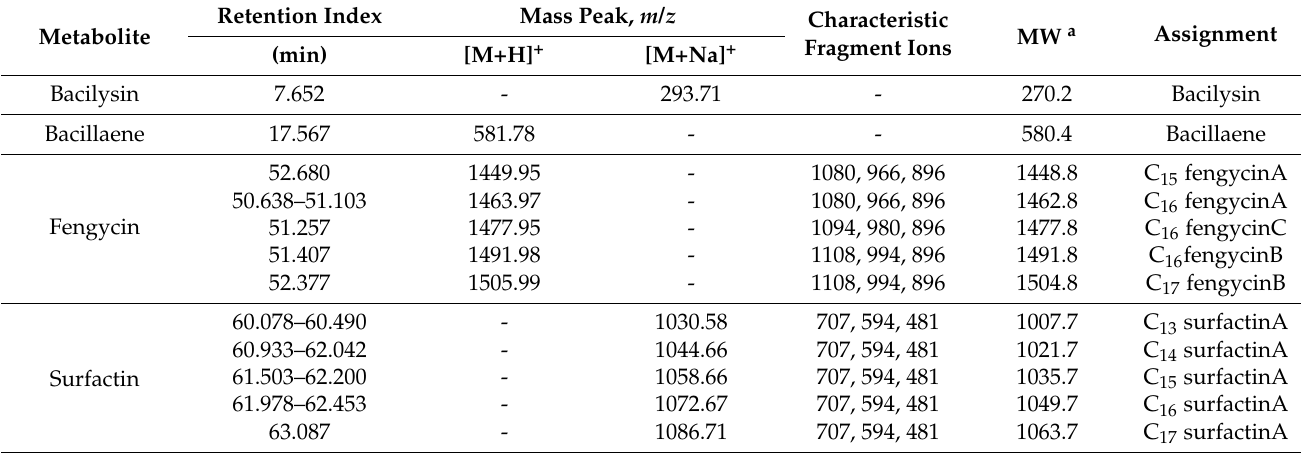
Table 3. Antifungal components of Landy culture filtrate from Bacillus subtilis L1-21 by using LC- MS